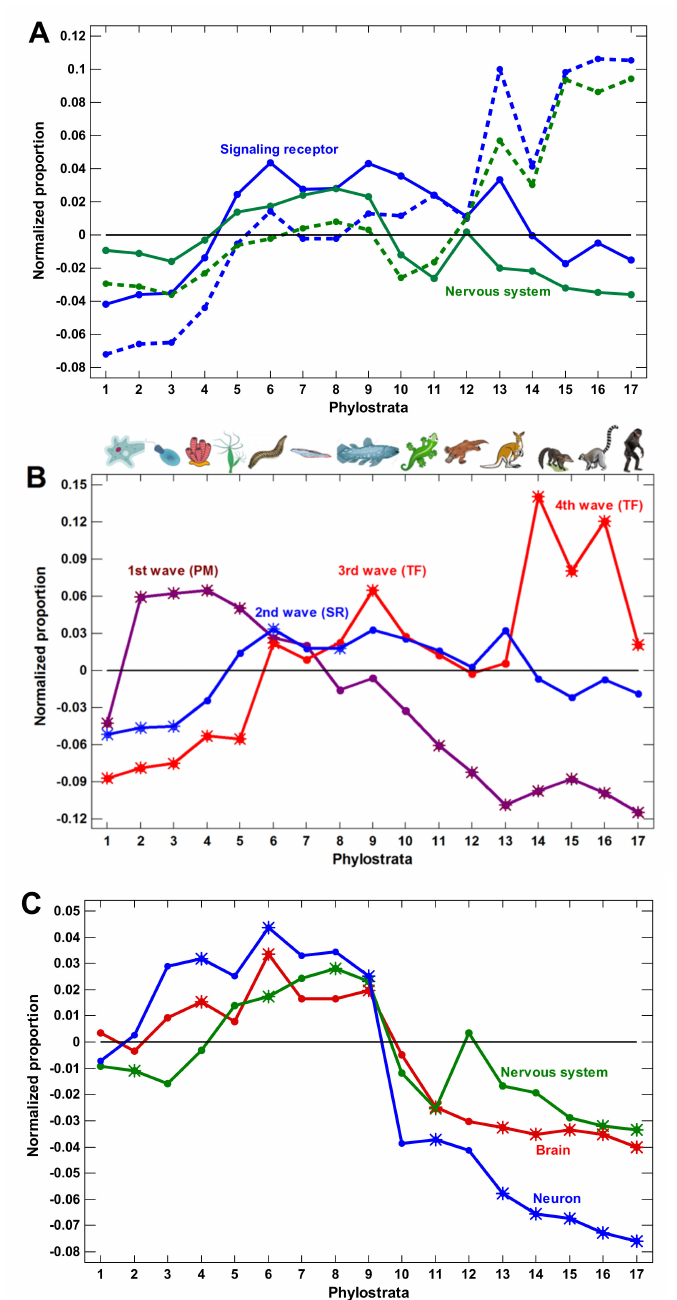
Figure 4. Phylostratic course of normalized gene proportions for different gene groups (baselines for all groups are set to zero). ( A ) signaling receptors and nervous system process genes (dotted lines, w/o exclusion of olfactory receptors; solid lines, with exclusion). ( B ) Waves of regulatory complexity: protein modifiers (PM), signaling receptors (SR), and transcription factors (TF). ( C ) Different sets of nervous system-related genes. Asterisks show significant enrichment (if above baseline) or underrepre- sentation (below baseline). (1—cellular organisms; 2—Eukaryota; 3—Opisthokonta; 4—Metazoa; 5— Eumetazoa; 6—Bilateria; 7—Chordata; 8—Vertebrata; 9—Euteleostomi; 10—Tetrapoda; 11—Amniota; 12—Mammalia; 13—Theria; 14—Eutheria; 15—Boreoeutheria; 16—Primates;